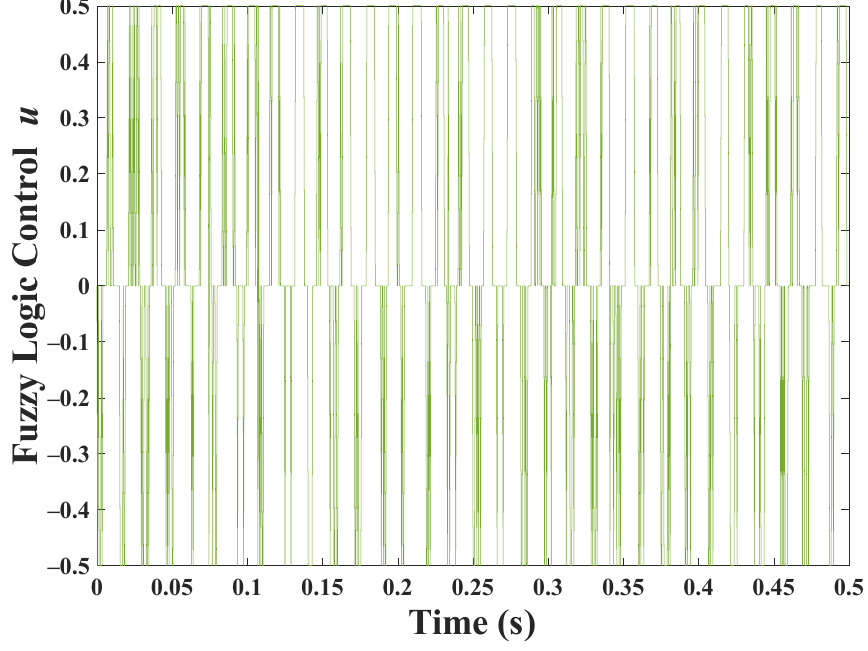
Figure 4. Output of FLC. Figure 4. Output of